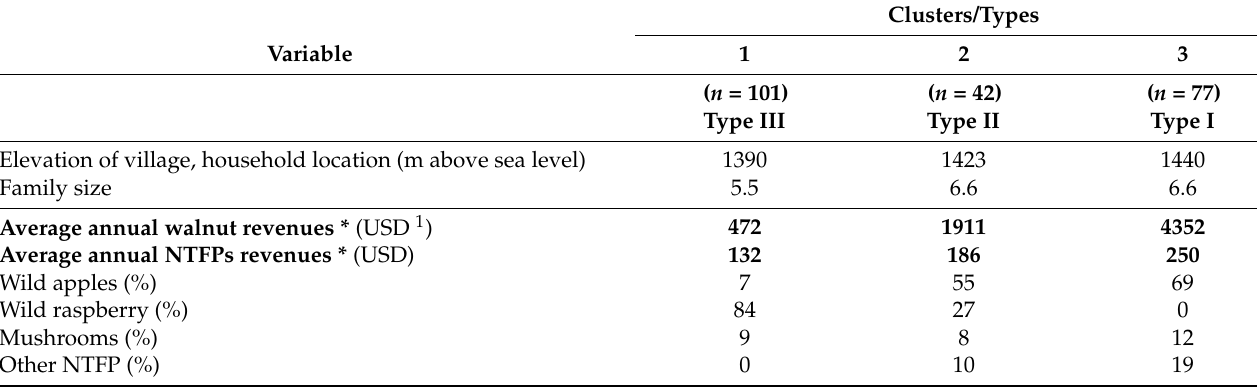
Table 3. Cluster characteristics derived from K -means